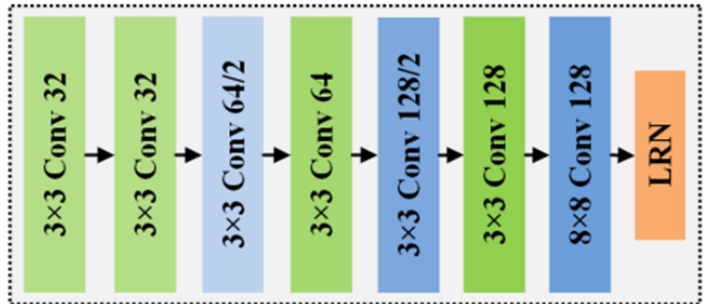
Figure 5. Basic architecture of L2-Net.